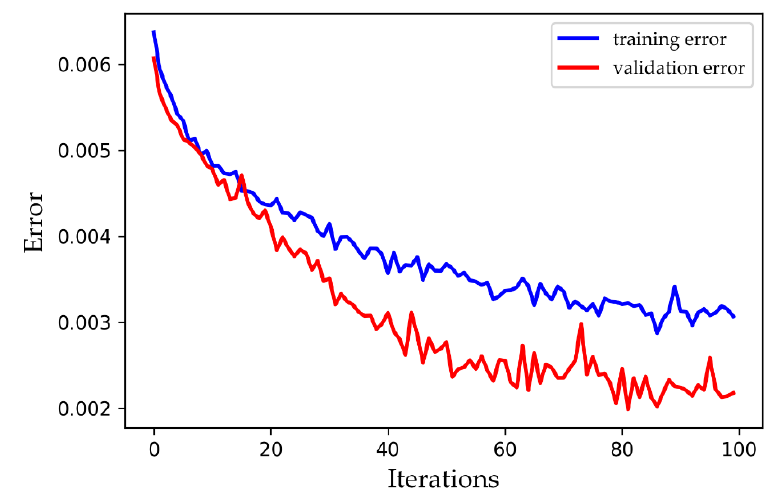
Figure 4. A comparison of the training error and validation error after implementing dropout.